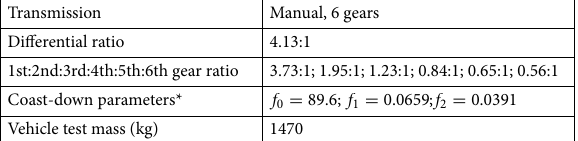
Table 2. Characteristics of the simulated vehicle. * F ( V ) ( N ) = f 0 + f 1 V ( km / h ) + f 2 V ( km / h )